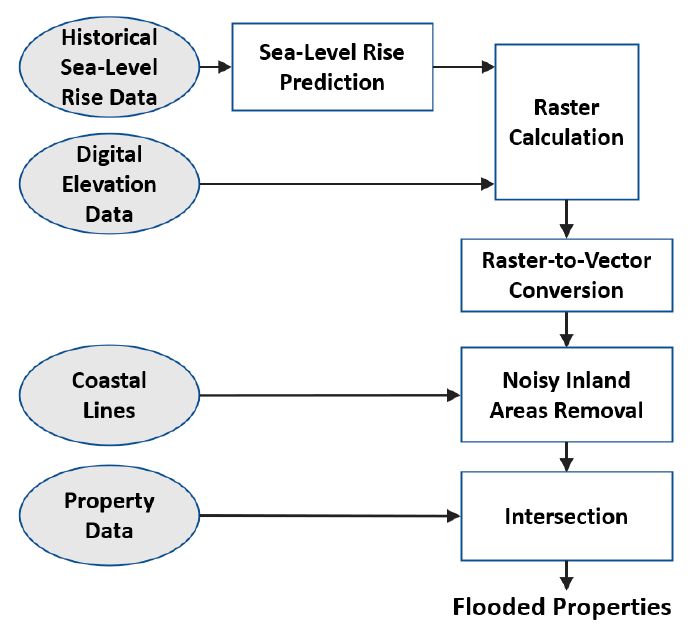
Figure 2. Data flow of our parcel-level flooding analysis.